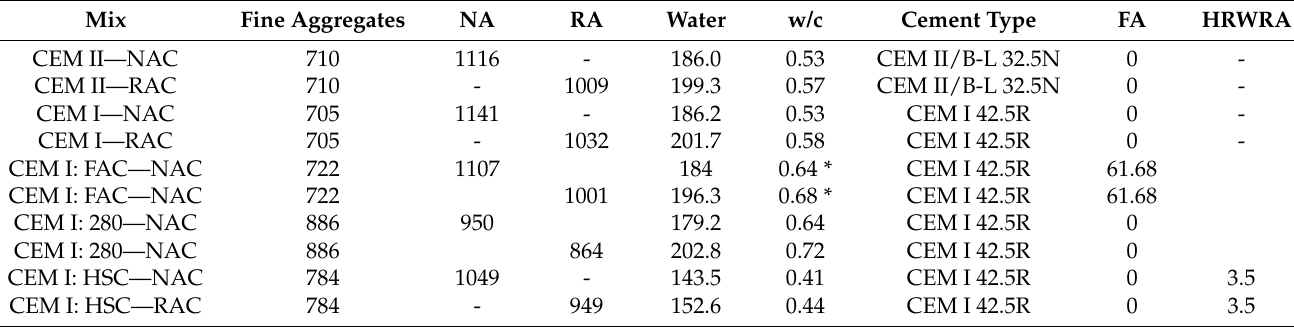
Table 2. Concrete mix design (kg/m 3 ).